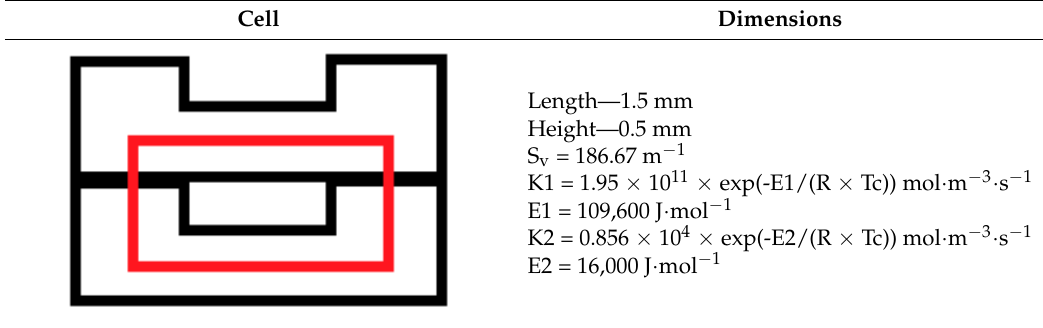
Table 9. Physical and computational domain of the simulated reactor and model settings.